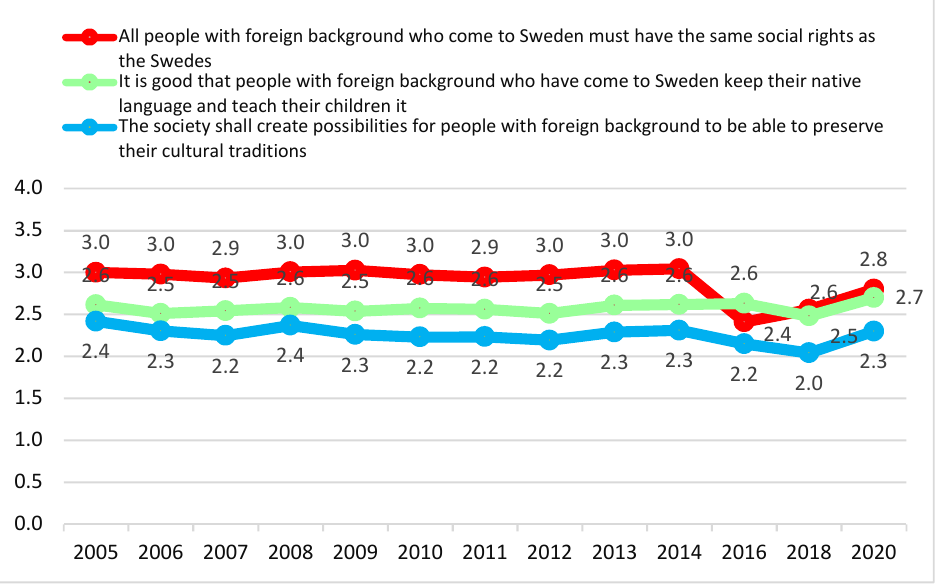
Figure 9. Three positive diversity indices (0–4) based on the three positive statements about diversity.